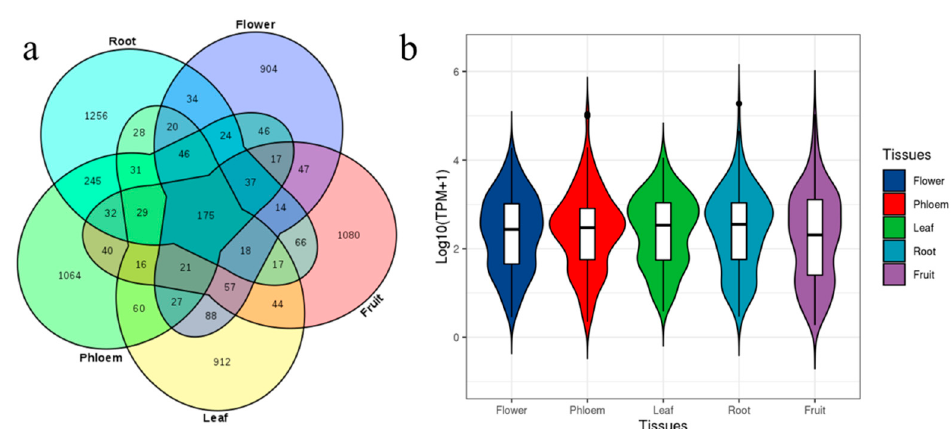
Figure 3. circRNAs in all five tissues and their expression characteristics: ( a ) Venn diagram showing the number of the identified circRNAs in five tissues. ( b ) The overall abundance patterns of parental genes of circRNAs using TPM calculation.